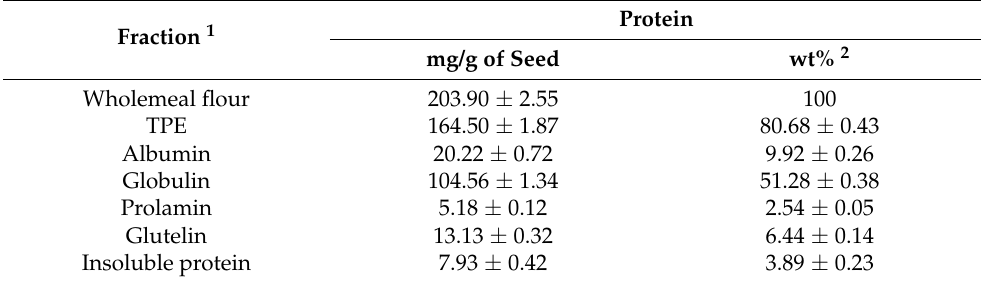
Table 1. Composition of the protein fraction of adzuki seed flour.